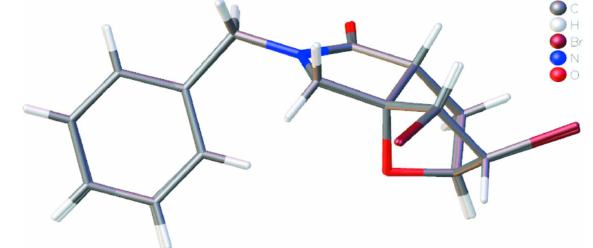
Figure 3 Overlay image ( OLEX2 ; Dolomanov et al. , 2009) of the two molecules ( A and B ) in the asymmetric unit of the title compound.